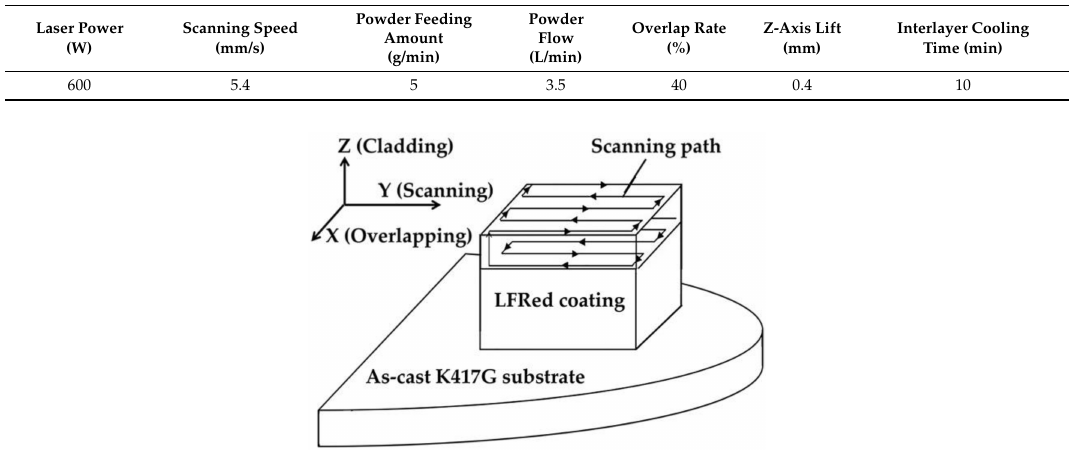
Table 1. Main process parameters of laser forming repairing.